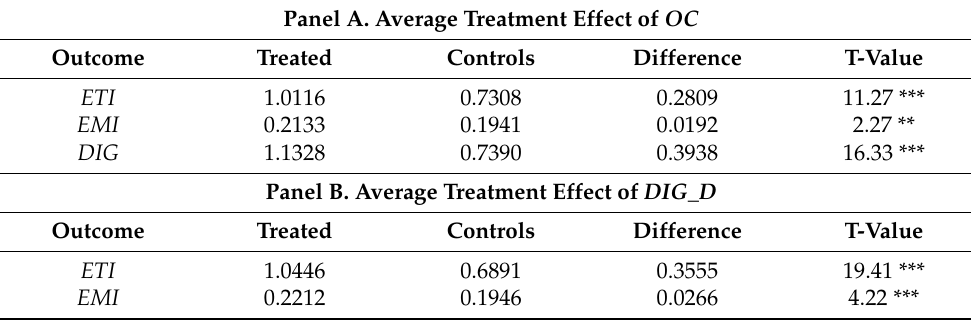
Table A2. The matching estimates for average treatment effect on the treated (ATT).